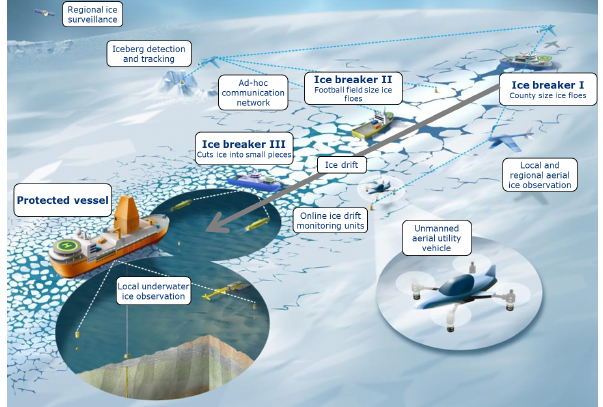
Figure 11: A foreseen Ice Management systemin the